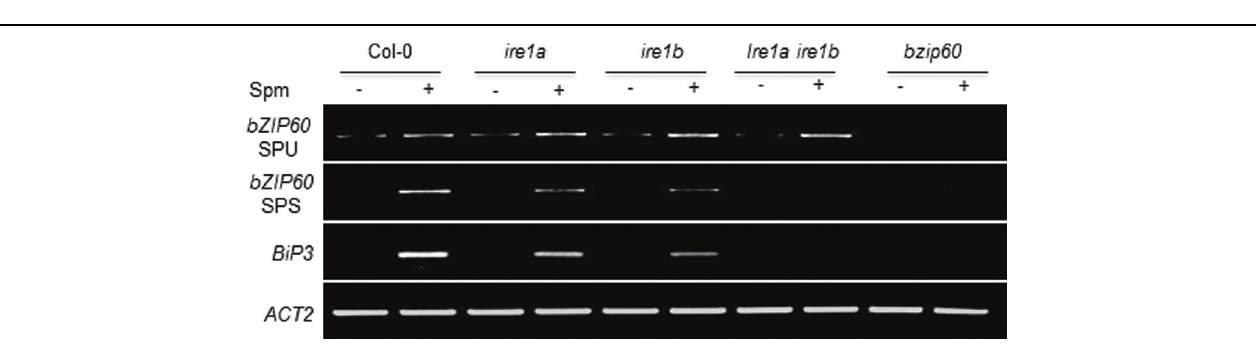
FIGURE 2 | Time-course analysis of bZIP60 splicing upon Spm treatment. (A) A schematic representation of bZIP60 transcript with the position and orientation of primer pairs used for detecting the unspliced ( SPU )- and spliced ( SPS )-forms of bZIP60 . (B) Time course RT-PCR analysis of SPU and SPS forms of bZIP60 transcript and its downstream target BiP3 transcript at indicated time intervals in control and Spm-treated seedlings. Actin was used as an internal control.